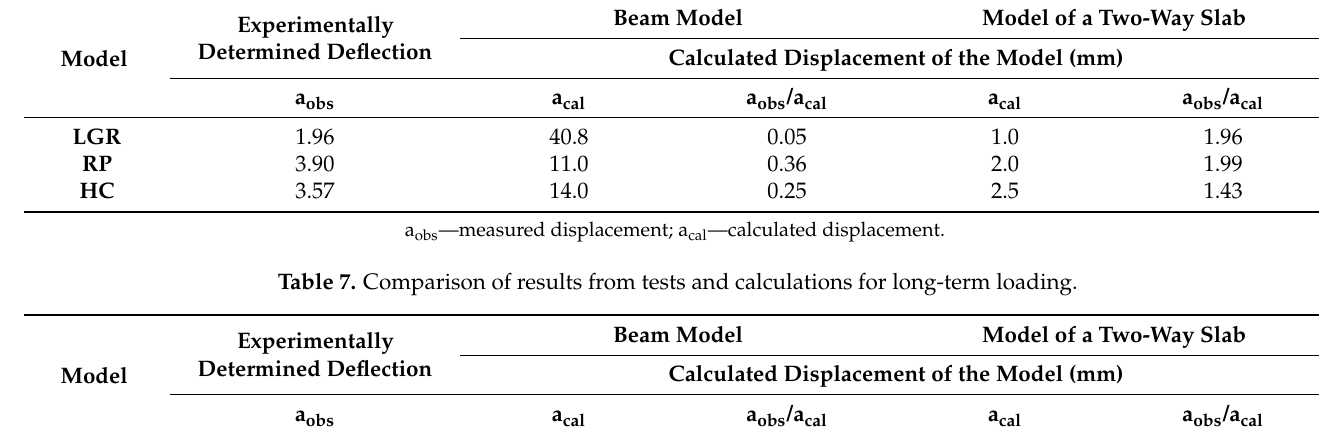
Table 6. Comparison of results from tests and calculations for short-term loading. Beam Model Model of a Two-Way Slab Experimentally Determined Deflection Calculated Displacement of the Model (mm) Model